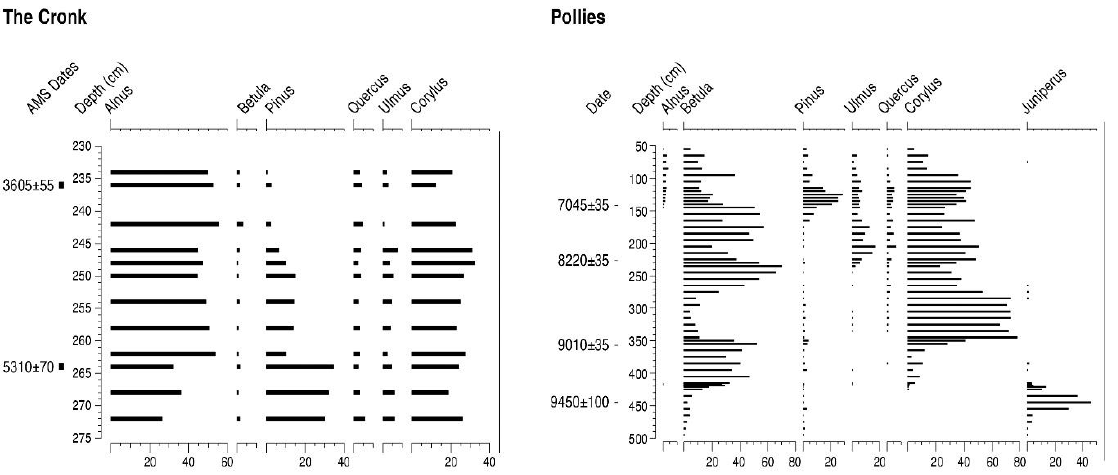
Figure 5. Percentage pollen diagrams from The Cronk and Pollies, Isle of Man, showing selected tree taxa and 14 C BP AMS ages.